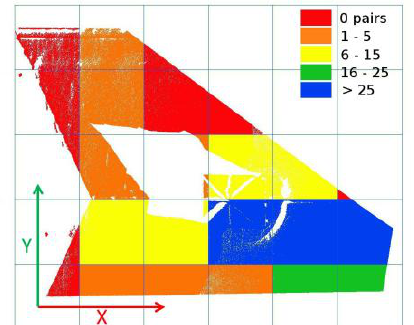
Figure 4: Colour coded visualisation of the corresponding point density on the roof section